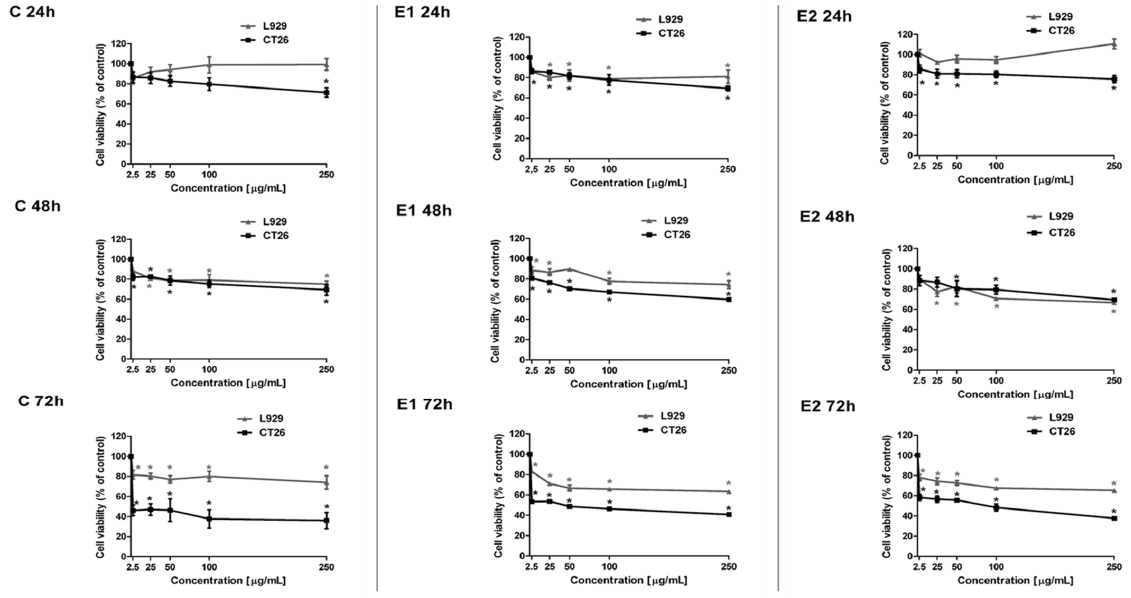
Figure 4. Results of antiproliferation activity in the in vitro analysis (E1 and E2—samples added with sodium nitrite at an amount of 50 mg/kg of stuffing and lyophilized willow herb extract at an amount of 150 and 1000 mg/kg, respectively; C—control sample added with sodium nitrite at an amount of 100 mg/kg of stuffing, but not willow herbs) (sign * means that the differences were sta- tistically significant at p < 0.05).